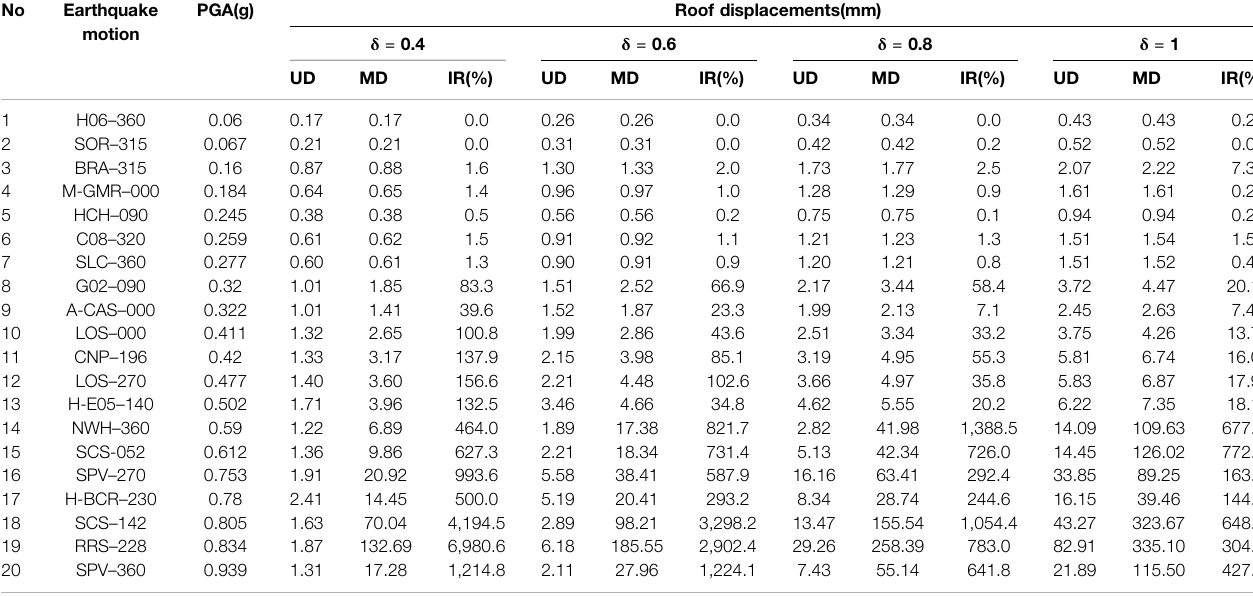
UD represents the undamaged model while MD represents Mainshock-damaged